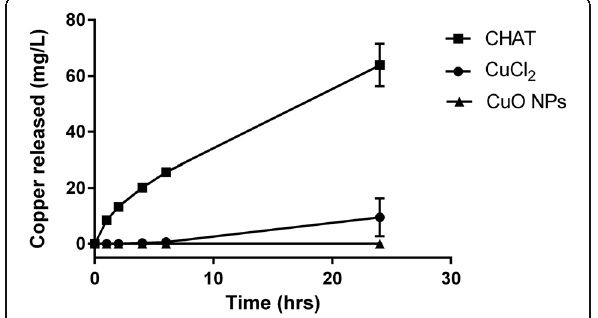
Fig. 4 Copper release from HEC matrices containing CHAT, copper chloride, or copper oxide nanoparticles (CuO NPs), all at 250 mg/L